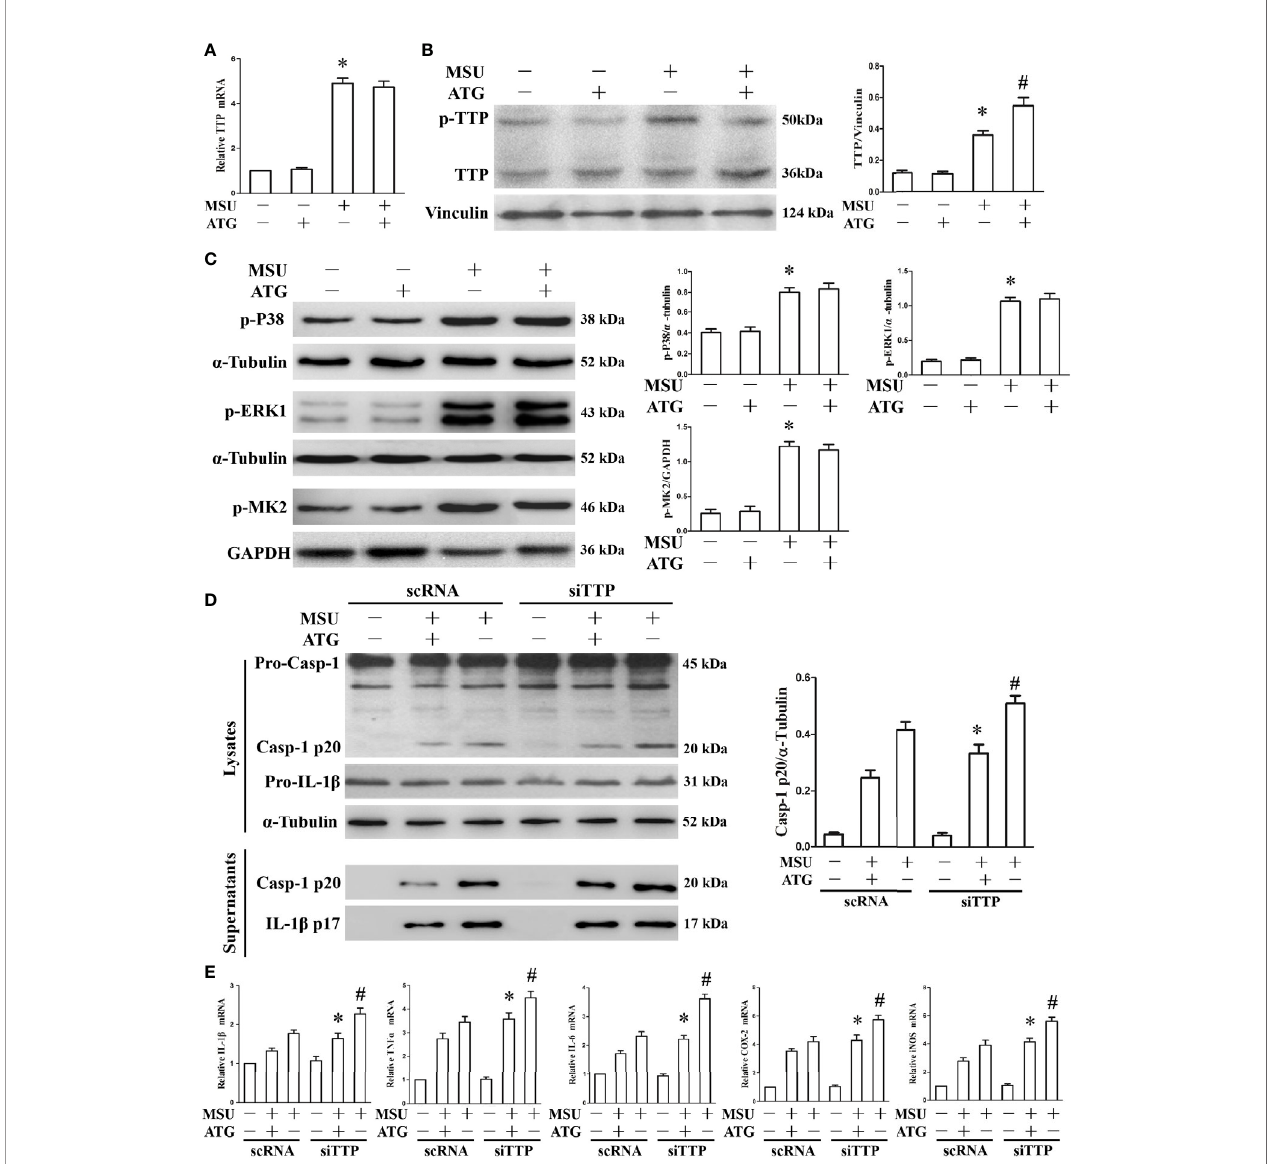
FIGURE 4 | The effects of ATG on TTP expression and TTP knockdown abolishes the ATG-mediated repression of the MSU crystal-induced in fl ammatory response. (A – C) J774A.1 cells were pretreated with ATG (5 m M) for 1 h, primed with LPS for 1 h and then treated with MSU crystals (50 m g/ml) for 9 h. Total RNA and protein in the cells were extracted. *P < 0.05 vs. without MSU crystals treatment; # P < 0.05 vs. MSU crystals treatment + vehicle. (A) The mRNA expression level of TTP was detected using RT-PCR. (B) Western blotting was used to measure the protein level of TTP. (C) The phosphorylation levels of MAPK p38, ERK1 and MK2 were tested using Western blot assays. (D, E) J774A.1 cells were either transfected with scRNA or siTTP for 48 h, treated with 5 m M ATG for 1 h, primed with LPS for 1 h, and then stimulated with MSU crystals (50 m g/ml) for 9 h. (D) The protein levels of the p20 subunit of Caspase-1 and IL-1 b in the cell lysates and culture supernatants were measured using Western blot. All the data are expressed as the means ± SEM from n=3 independent experiments, *P < 0.05 vs. MSU crystals treatment + ATG + scRNA; # P < 0.05 vs. MSU crystals treatment + scRNA. (E) The mRNA levels of IL-1 b , IL-6, TNF- a , COX-2 and iNOS were determined. *P < 0.05 vs. MSU crystals treatment + ATG + scRNA; # P < 0.05 vs. MSU crystals treatment + scRNA. All the data are expressed as the means ± SEM from n=3 independent